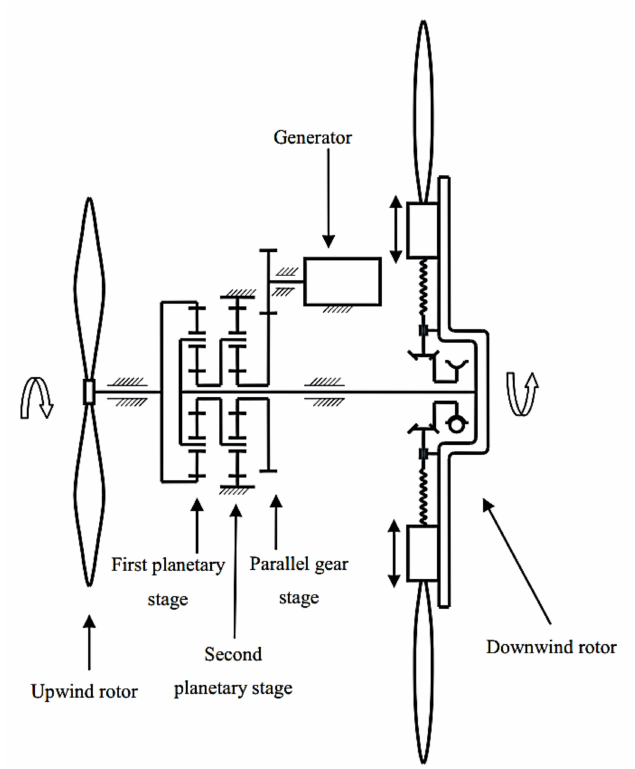
Figure 2. Structure diagram of gearbox of a DRWT.